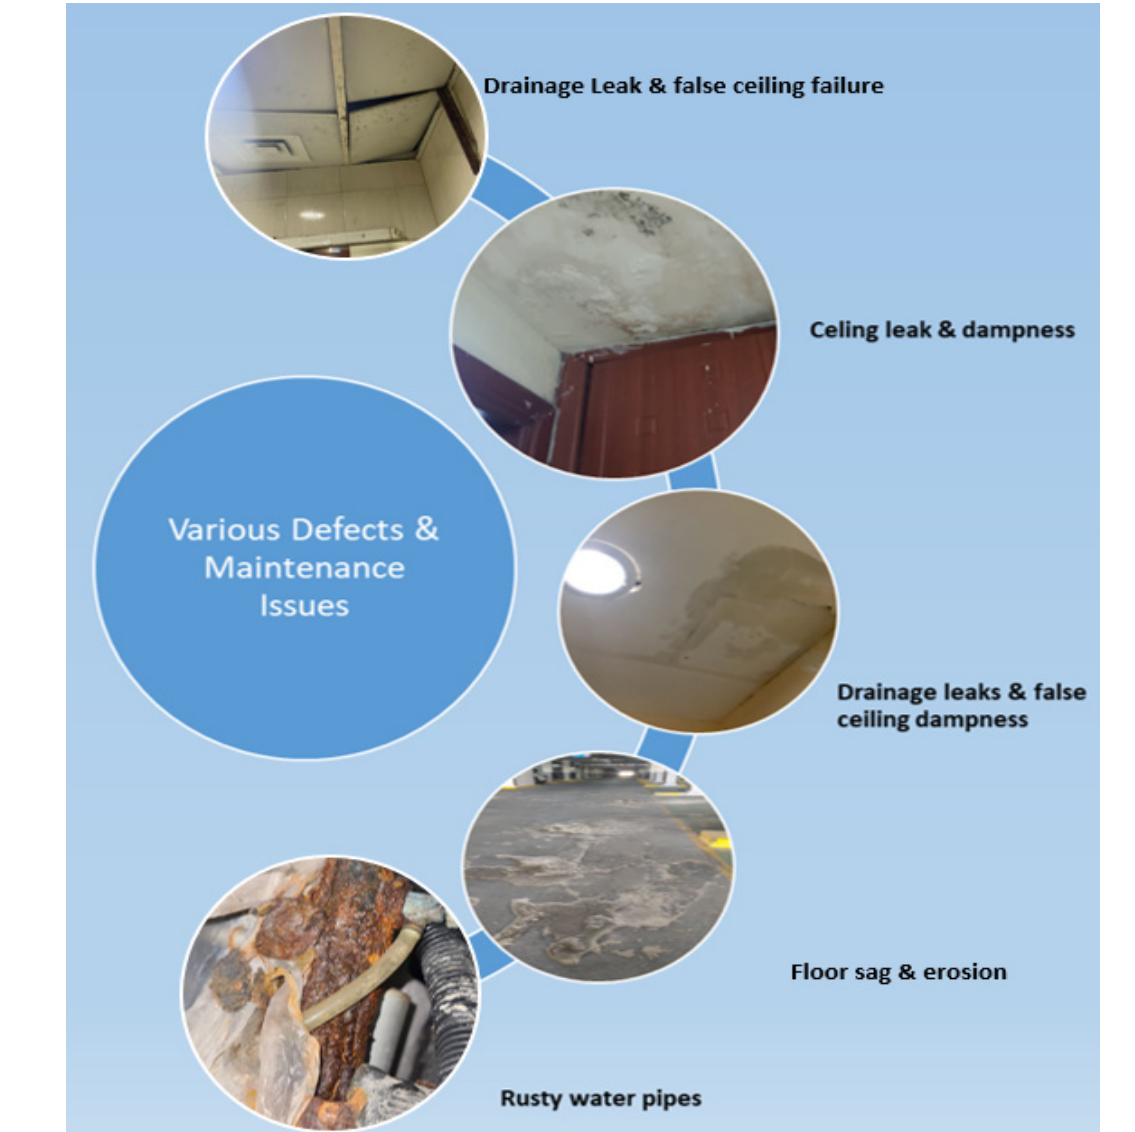
Figure 4. Different defects and maintenance issues.